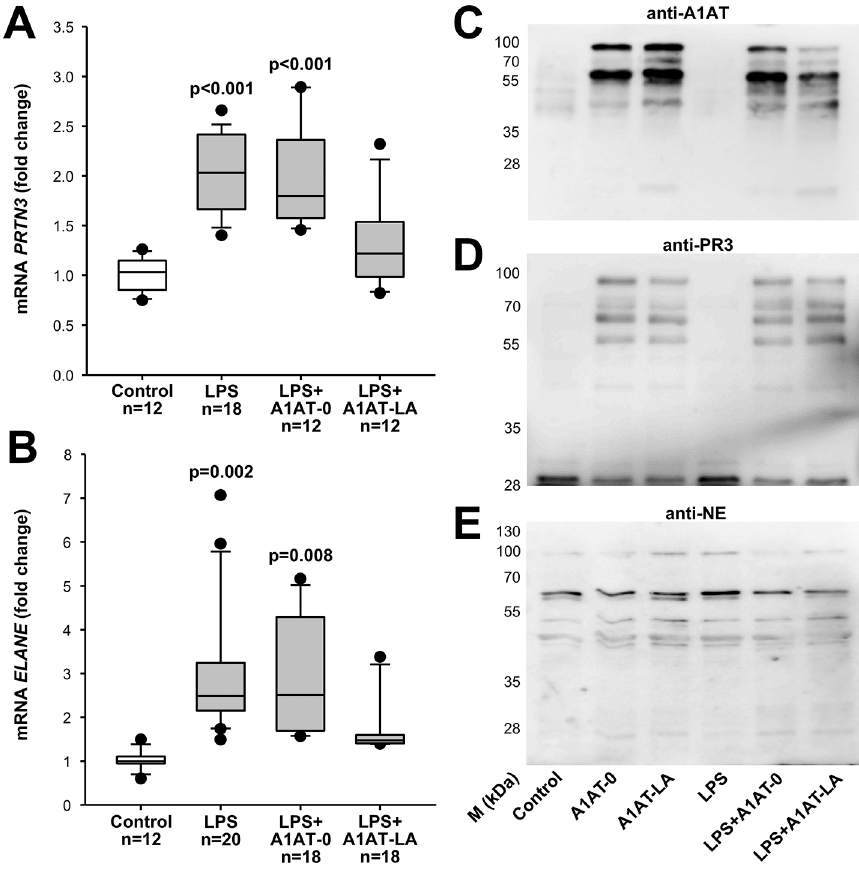
Figure 7. Effects of A1AT-0 and A1AT-LA on LPS-induced NE and PR3 expression and pro- tein profile. Human neutrophils (5 × 10 6 ) were incubated for 5 h in either medium alone or medium containing LPS (20 ng/mL) in the absence or presence of A1AT-0 (1 mg/mL) or A1AT-LA (1 mg/mL). mRNA expression of PRTN3 (A) and ELANE (B) were analyzed by real-time qPCR as described in Materials and Methods. GAPDH and HPRT were used as housekeeping genes. Box plots represent data from 5 individual donors; n = number of replicates for each experiment. P value indicates significant differences compared with the values seen in control cells. Cell lysates were analyzed for A1AT (C), PR3 (D) and NE (E) protein profile characterization by 12.5% SDS-PAGE following western blotting. M-molecular size marker (kDa). Each blot is representative of 3 independent